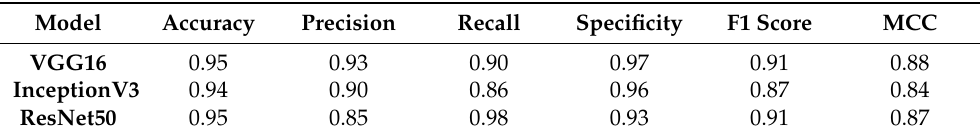
Table 1. An overview of the evaluation metric results was obtained for the VGG16, InceptionV3, and ResNet50 models using the transfer learning strategy. Model Accuracy Precision Recall Specificity F1 Score MCC VGG16 0.95